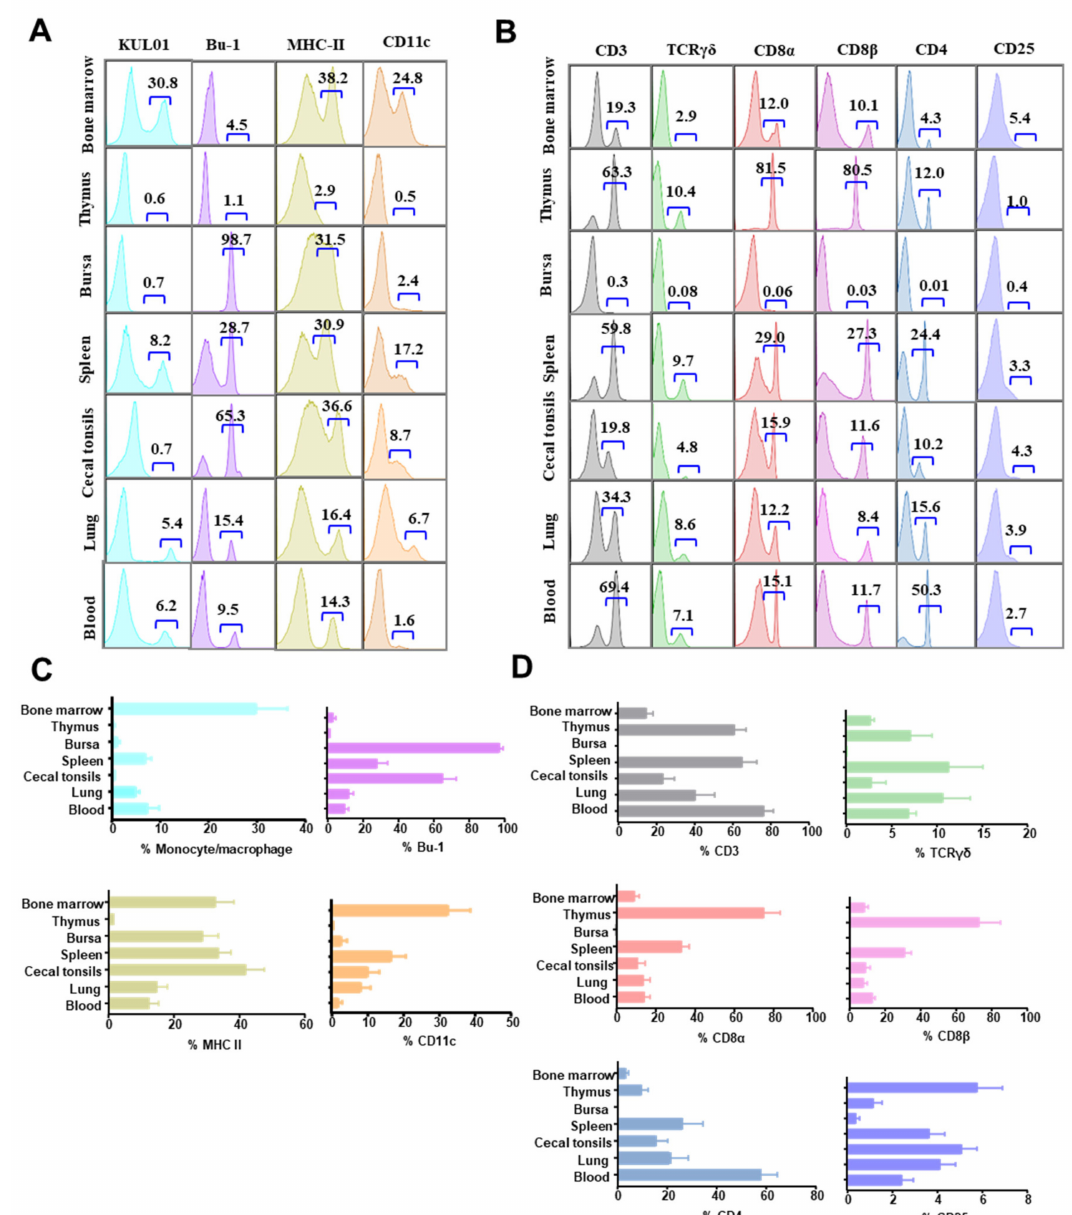
Figure 3. The distribution of immune cells in the organs of chicken at steady state. Mononuclear cells were isolated from di ff erent organs of 4 weeks-old naïve chickens and were surface stained with antibody Panel 1 or Panel 2. Representative staining profiles of KUL01 + , Bu-1 + , MHC-II + , and CD11c + cells by tissue, are depicted as histogram plots ( A ). Representative staining profiles of CD3 + , TCR γδ + , CD8 α + , CD8 β + , CD4 + , and CD25 + cells by tissue, depicted as histogram plots ( B ). Results for bone marrow, thymus, bursa, spleen, cecal tonsils, lung, and blood are shown. The percentages of B lymphocytes and T cell subsets are derived from a lymphocyte gate based on FSC versus SSC. Percentages of KUL01 + , MHC-II + , putative CD11c + cells from a leukocyte gate based on CD45. Bar chart (mean ± SD) represents total frequency of positive events for each surface marker (( C , D )) ( n =